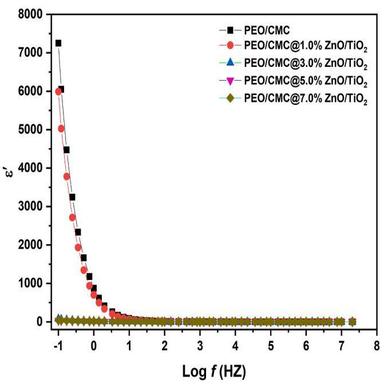
Variation of logarithm frequency with ε′ of PEO/CMC composite and PEO/CMC filled 1.0, 3.0, 5.0 and 7.0 wt% of ZnO/TiO2 NPs.